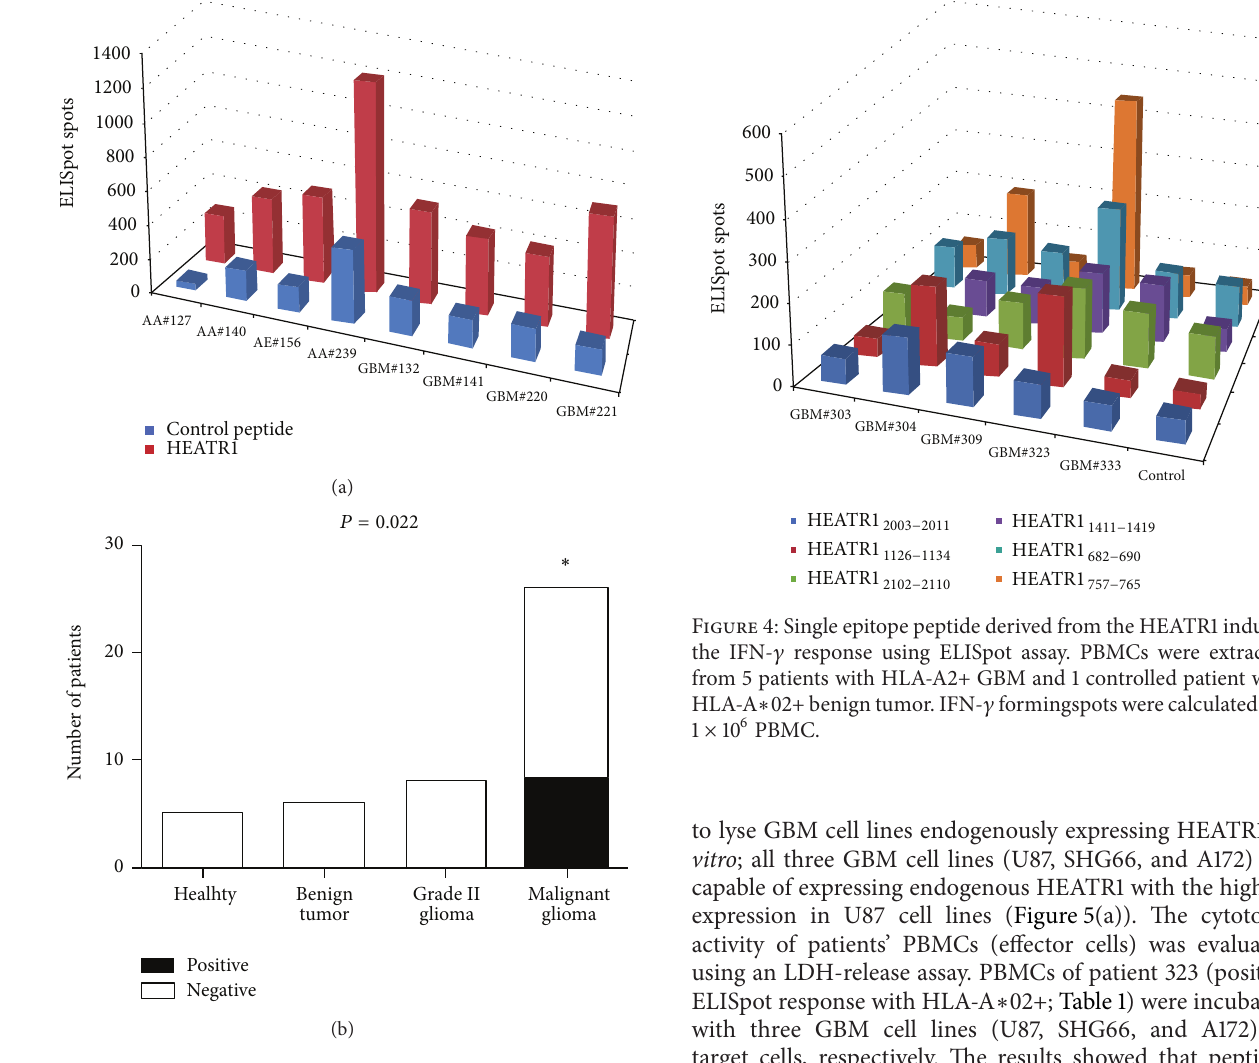
Figure 3: Six epitope peptides derived from the HEATR1 induce the IFN- 𝛾 response. (a) ELISpot result of 8 malignant gliomas with positive reactivity. The number of IFN- 𝛾 formingspots was calcu- lated per 1 × 10 6 PBMCs. (b) The positive reactivity among 6 healthy donors and 38 patients only occurred in 8 malignant gliomas ( 𝑃 = 0.022 ). GBM: glioblastoma multiforme;AA: anaplasticastrocytoma; AE: anaplastic ependymoma. This is a representative experiment from two independent experiments. No peptide stimulation was negative control. Correlation between ELISpot response and glioma grades was evaluated using a 𝜒 2 test.